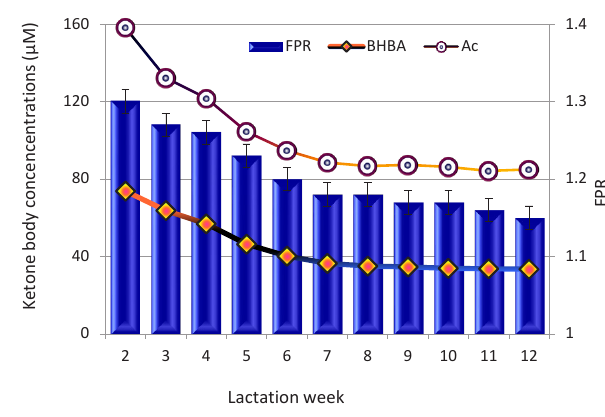
Figure 1. The relationship between milk BHBA and Ac concentration with FPR along with lactation week (FPR, fat to protein ratio; Ac, acetone; BHBA, β -hydroxybutyrate). The bar graph represents the FPR values and line graphs represent the ketone body concentrations.